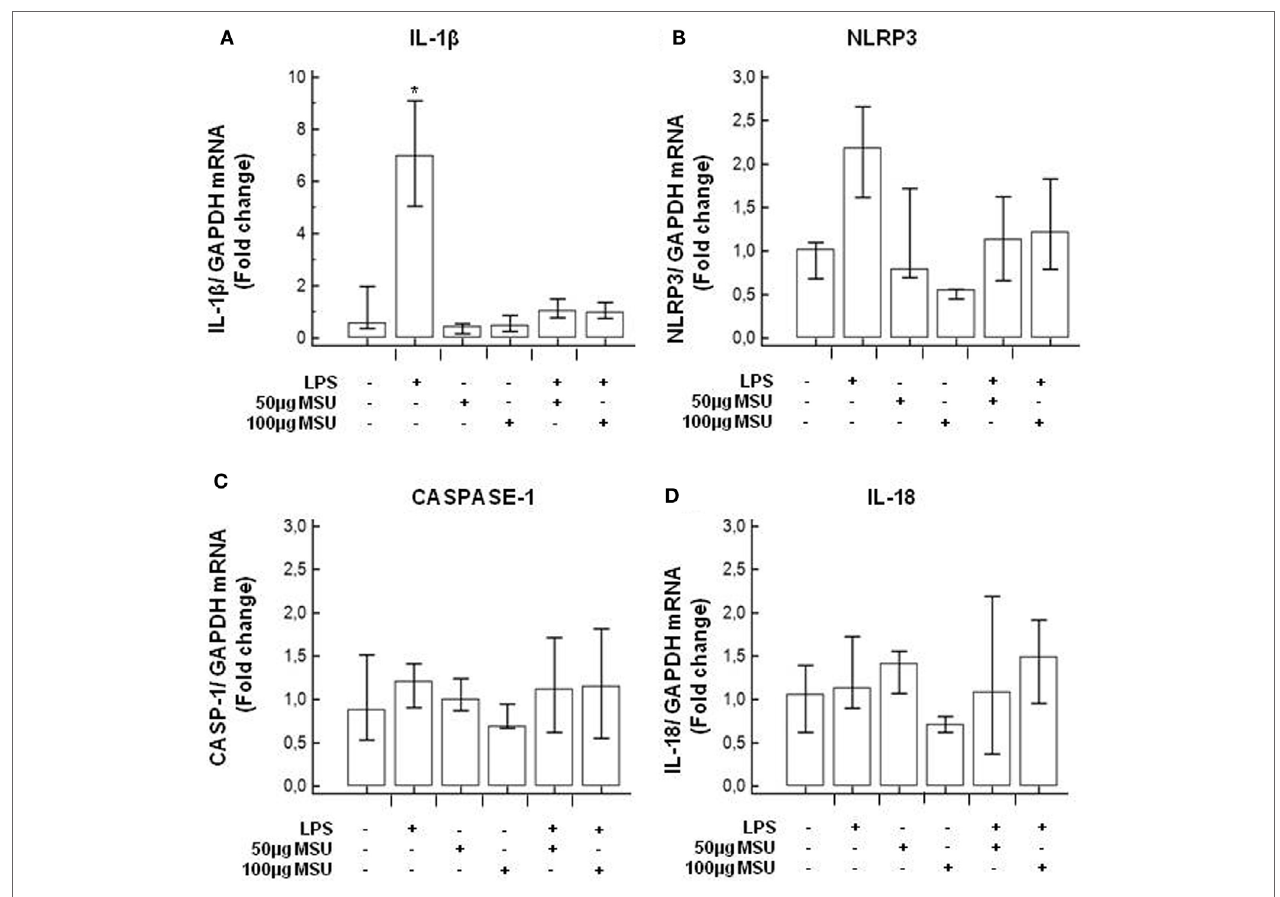
FigUre 4 | Modulation of inflammasome genes by monosodium urate crystals (MSU) in PBMCs of healthy control (HC) subjects. PBMCs of HC were stimulated with lipopolysaccharide (LPS) (1 µg/ml) for 2 h and/or with the indicate concentration of MSU crystals for 22 h. RNA was isolated from PBMCs and IL-1 β (a) , Nod-like receptor protein 3 (NLRP3) (B) , caspase-1 (c) , and IL-18 (D) were determined using SYBR green qPCR. Human GAPDH was used for